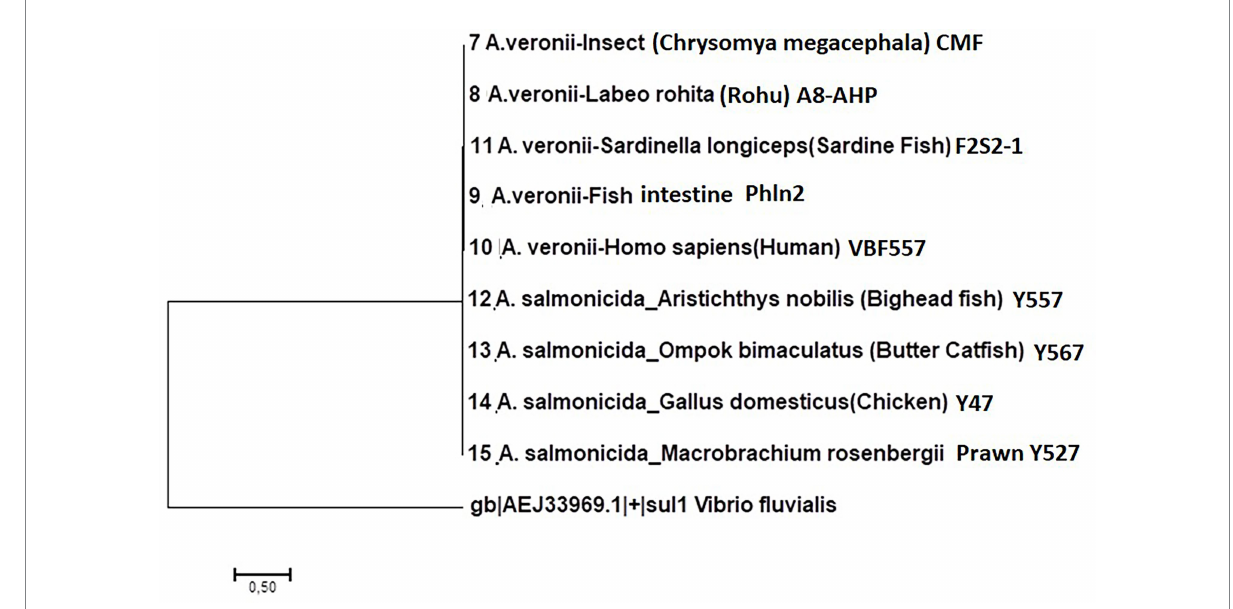
FIGURE 5 Phylogenetic analysis of crp resistance genes detected from sequences of nine Aeromonas spp. isolated from different host species in